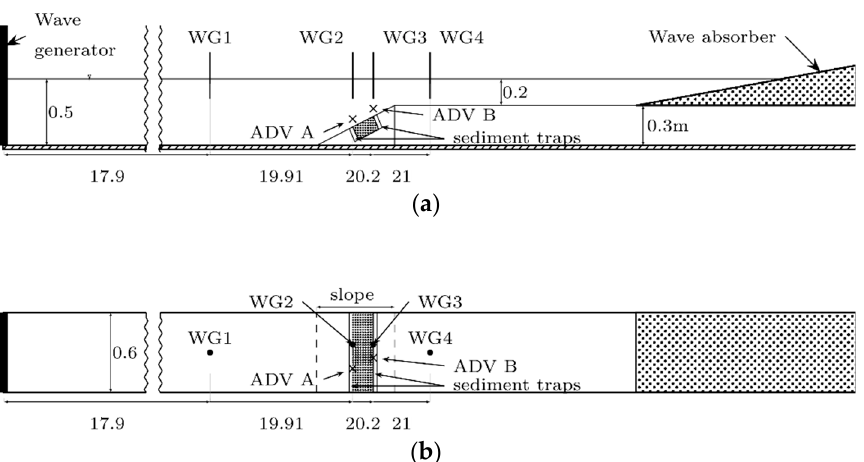
Figure 2. Experimental setup in a wave flume for measurements of wave-induced sediment transport on a sloping bed: ( a ) side view of the wave flume with the sand box implemented; ( b ) top view of the wave flume with position of gauges and sand traps.